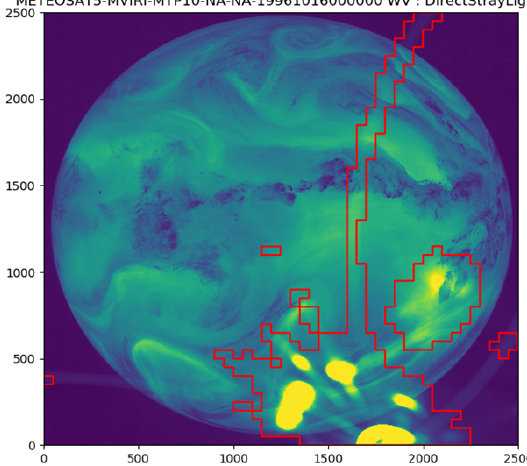
Figure 9. Segmentation result of the direct stray-light anomaly detection. Taken from METEOSAT5-MVIRI-MTP10-NA- NA19961016000000 and channel WV. The pixel values are the raw digital counts (see also Fig. 2;